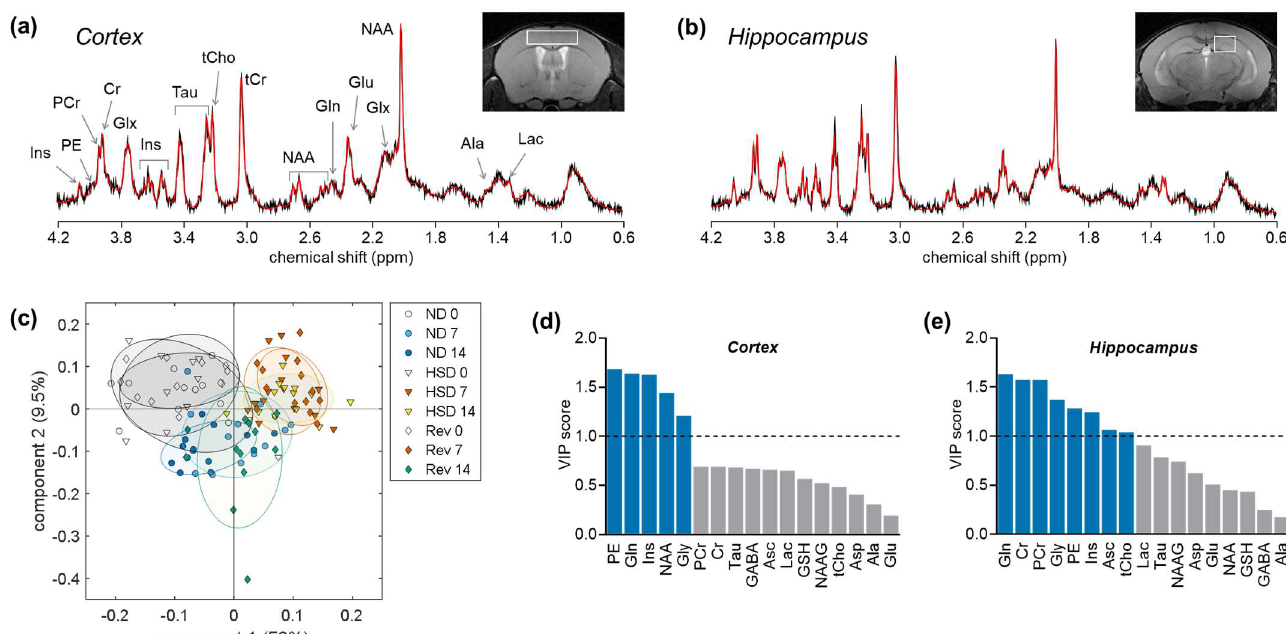
Figure 2. Metabolic profiles of cortex and hippocampus in response to HSD and aging. Representative MRS spectra in the cortex ( a ) and hippocampus ( b ) acquired with STEAM at 9.4 T overlaid by the respective LCModel fitting results (red lines). The VOI locations in the cortex and dorsal hippocampus are represented in the inset anatomical images. Most prominent peaks are labelled: Ala, alanine; Lac, lactate; GABA, γ-aminobutyrate; NAA, N -acetylaspartate; Glx, glutamate (Glu) + glutamine (Gln); tCr, total creatine = creatine (Cr) + phosphocreatine (PCr); tCho, total choline = phosphorylcholine + glycerophosphorylcholine; Tau, taurine; Ins, myo -inositol; PE, phosphorylethanolamine. The resulting neurochemical profile was analyzed with a PLS regression to the presence of high salt concentrations in the diet. ( c ) Component space after PLS regression showing individual mice (symbols) and group SDs (ellipsoids) for normal (ND), high-salt (HSD), and reversed (Rev) diet groups at 0, 7, and 14 months of treatment. ( d , e ) VIP scores calculated from the resulting PLS model for metabolites in the cortex and hippocampus.